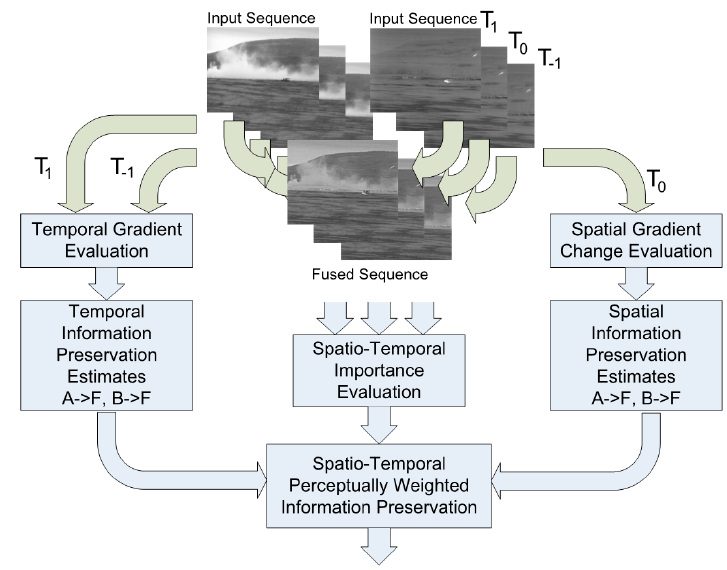
Figure 10. Dynamic fusion evaluation metric DQ.